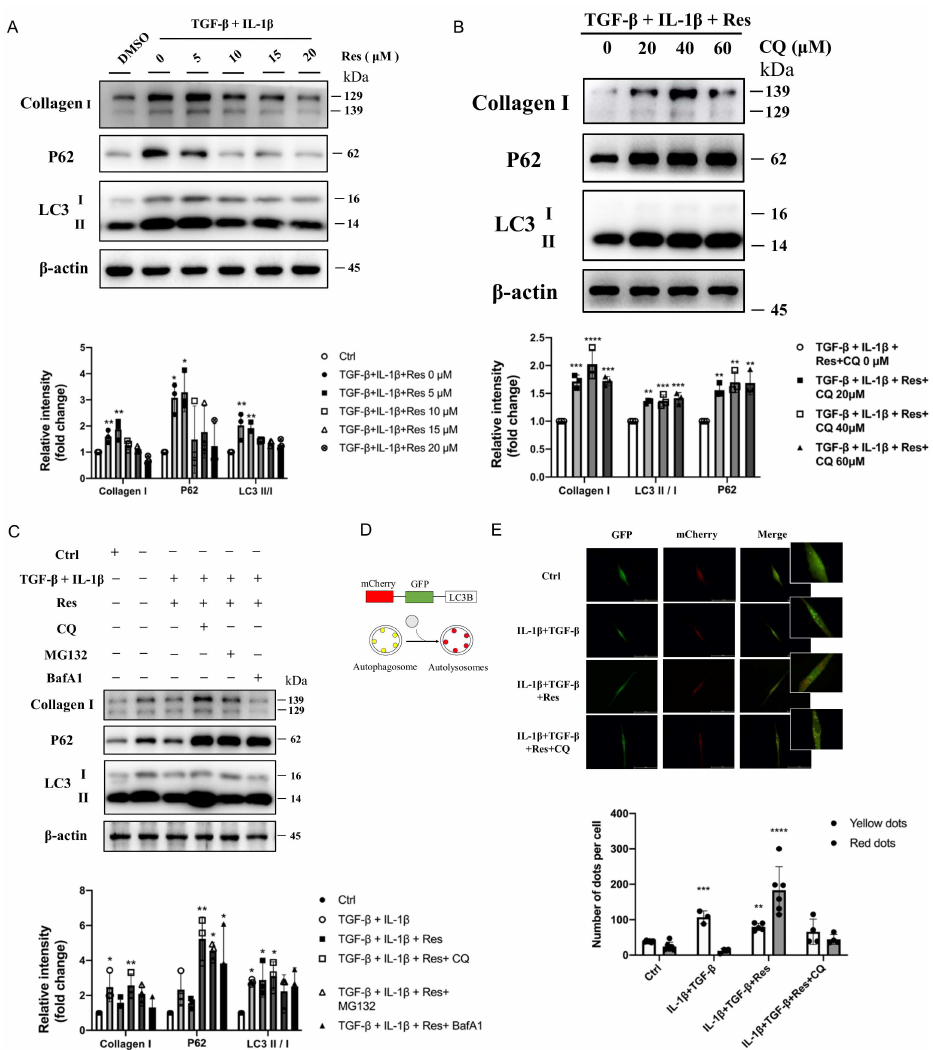
Figure 5. Resveratrol reversed disruption of autophagosome–lysosome fusion in vitro to improve fibrosis. ( A ) Immunoblotting of MRC-5 cells treated with TGF- β (10 ng/mL), IL-1 β (5 ng/mL), and different concentrations of resveratrol were quantified as described above. ( B ) TGF- β +IL-1 β , resveratrol, and CQ (0, 20, 40, 60 µ M) treated MRC-5 cells for 24 h, and then they were immunoblotted and quantified as described above. ( C ) TGF- β (10 ng/mL) and IL-1 β (5 ng/mL) induced MRC-5 cells treated with resveratrol (15 µ M) were treated with different autophagy inhibitors (CQ, 40 µ M; BafA1, 100 nM) and proteasome inhibitors (MG132, 10 µ M), respectively, immunoblotted, and quantified as described above. ( D ) Diagram of mCherry-GFP-LC3B, an autophagic flux sensor. Autophagosomes appears yellow, whereas autolysosomes appear red, because GFP fluorescence is quenched under acidic environment after fusion with lysosomes. ( E ) mCherry-GFP-LC3B application to detect autophagy flow in MRC-5 cells before and after resveratrol or CQ treatment. Values represent the mean ± SEM (n = 3–5). Compared with the control group, * p <0.05, ** p < 0.01, and *** p < 0.001 and **** p